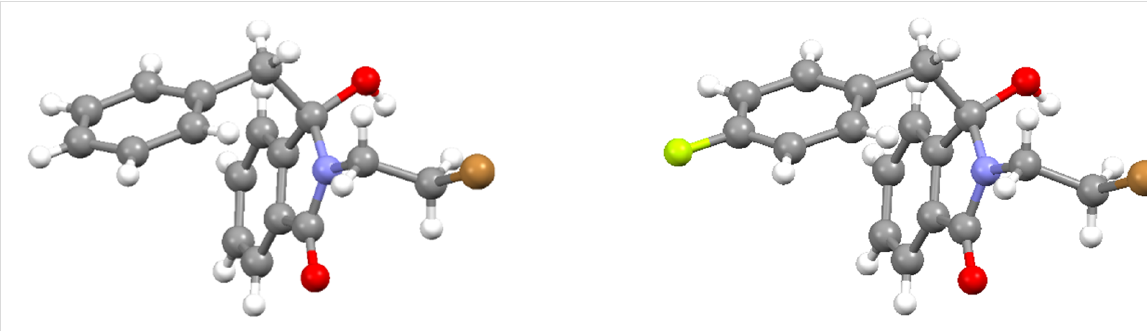
Figure 2: Crystal structures of photoaddition products 3a (left) and 3b (right).